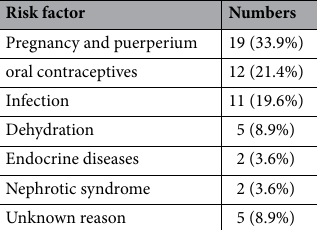
Table 2. Detailed risk factors of 56 patients.